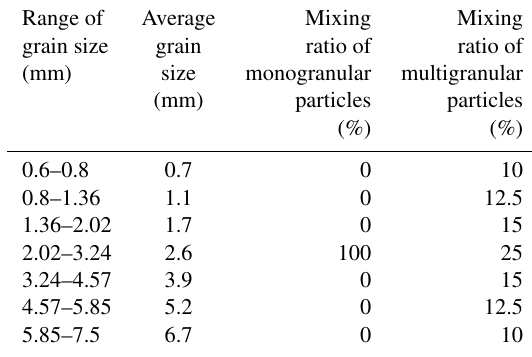
Table 1. Details of sediment particles and mixing ratios. Range